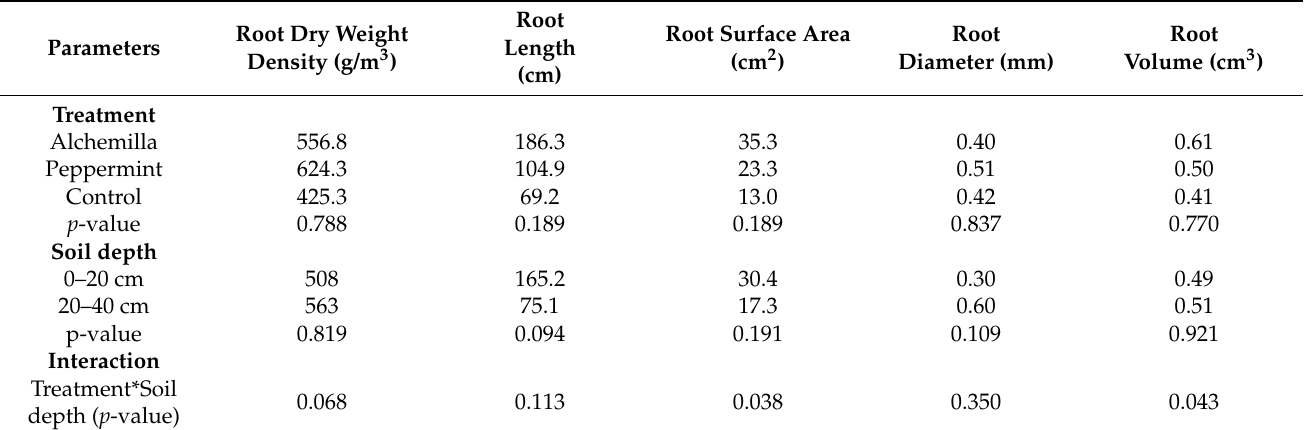
Table 4. Effect of living mulches, soil depth, and their interactions on apple root dry weight density and morphological